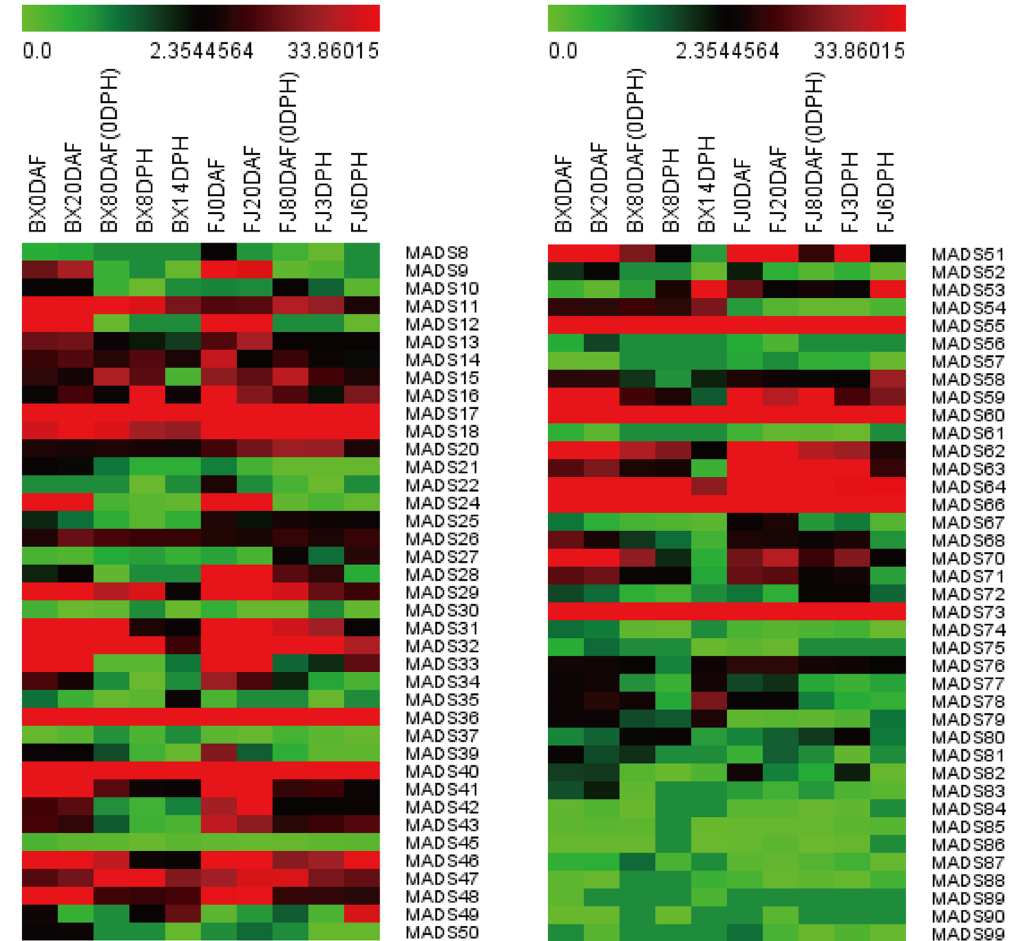
Figure 5. Expression patterns of MaMADSes in different stages of fruit development and ripening in BX and FJ varieties. The heat map with clustering was created based on the FPKM value of MaMADSes . Differences in gene expression changes are shown in color as the